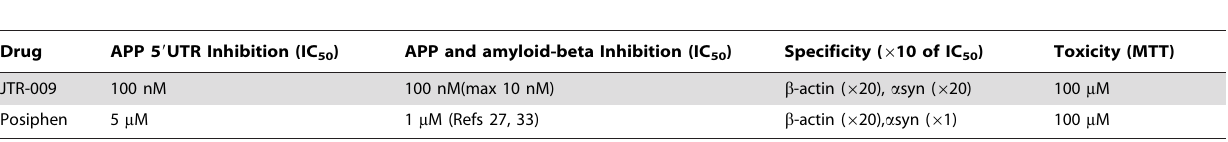
Table 2. Comparative IC 50 of JTR-009 relative to posiphen to inhibit APP 5 9 UTR driven luciferase expression relative to suppression of APP and A b levels in SH-SY5Y cells and primary